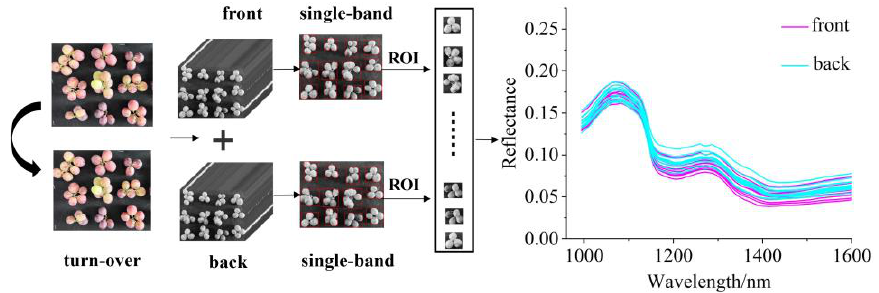
Figure 2. The flow chart of hyperspectral image data acquisition and data